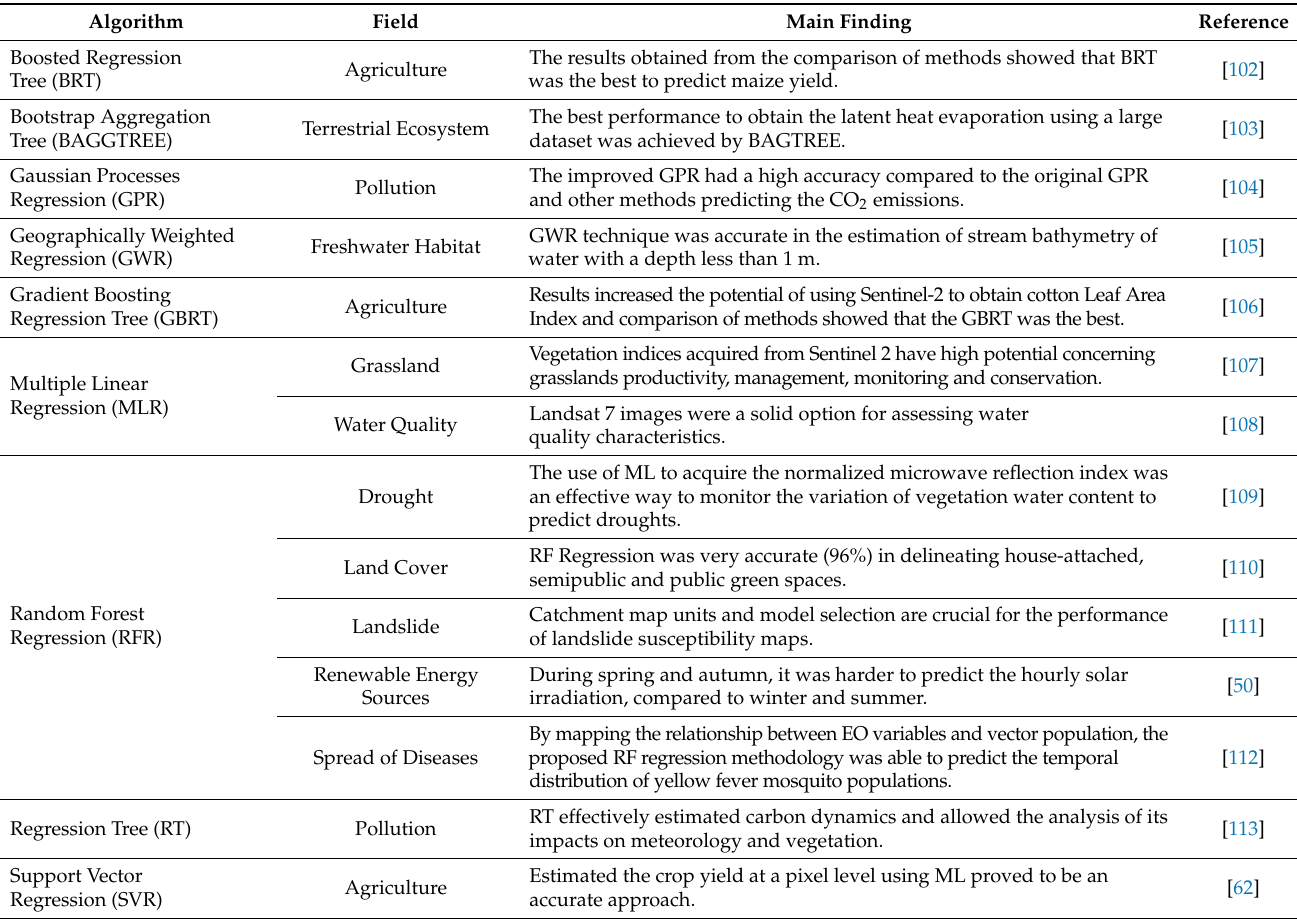
Table 2. Examples of regression algorithms using EO